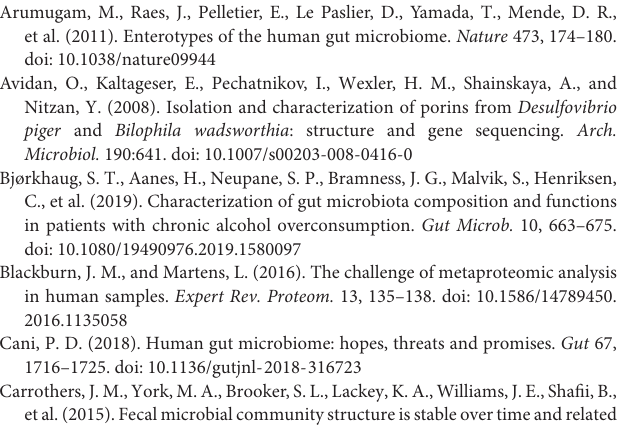
Supplementary Figure 2 | Sum of the intensity of all distinctive peptides of each taxonomic level in each protocol (PA–PF). ∗∗ p < 0.0098; ∗ p < 0.037. Supplementary Figure 3 | Butyrate metabolism KEGG pathway downloaded from KEGG website (http://www.kegg.jp). Colored KO numbers indicate proteins identified in this study. Firmicutes proteins are colored in blue and Bacteroidetes proteins in purple. Supplementary Table 1 | Metrics of metaproteome analysis of H1 using protocols A–F. Supplementary Table 2 | Functional analysis of the proteomes obtained with different protocols. The abundance of each COG category is represented as the sum of the intensities of all proteins annotated to that COG category in each sample. Supplementary Table 3 | Taxonomy of human gut microbiota of six healthy adult individuals. Supplementary Table 4 | Functional analysis of the proteomes from the human gut microbiota of six healthy adults. The abundance of each COG category is represented as the sum of the intensities of all the proteins annotated to that COG category in each sample. The box color indicates a gradient of intensity. The intensity marked in red is of special interest and is discussed in depth in the text. Supplementary Table 5 | The thirty most abundant microbial proteins identified in the study. Supplementary Table 6 | KOs entries belonging to proteins from butanoate metabolism pathway identified in the study. Supplementary Table 7 | List of the most abundant human proteins identified in the six human gut microbiota samples used for the STRING